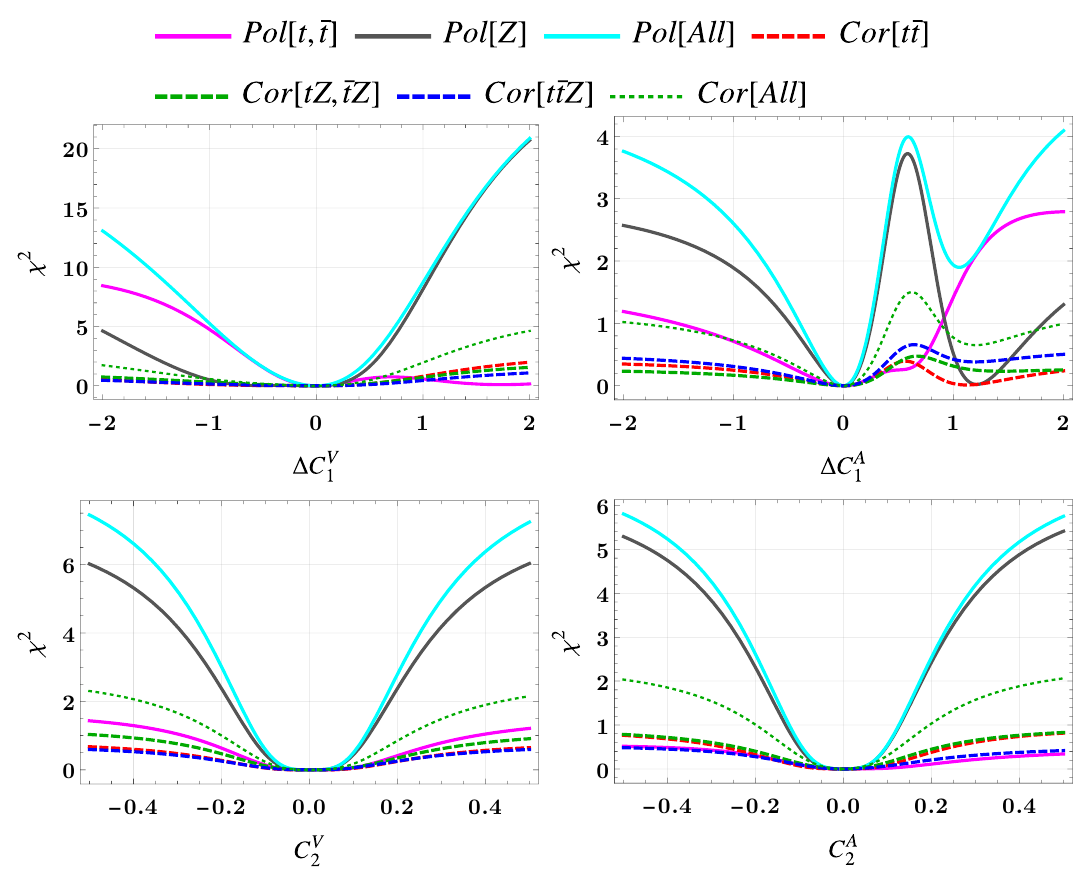
√ s = 13 TeV and integrated luminosity of